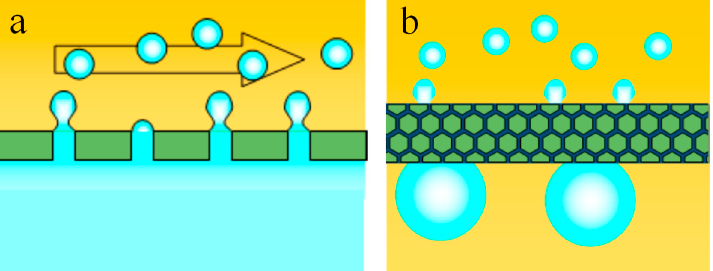
Figure 4. Schematic representations of ( a ) cross-flow membrane emulsification, in which the cross-flowing continuous phase shears-off the droplets that are formed. ( b ) Pre-mix emulsification, in which the droplets of a coarse emulsion (bottom) are broken up into smaller ones (top) upon passage through a membrane; image courtesy of Remko Boom (Wageningen University).